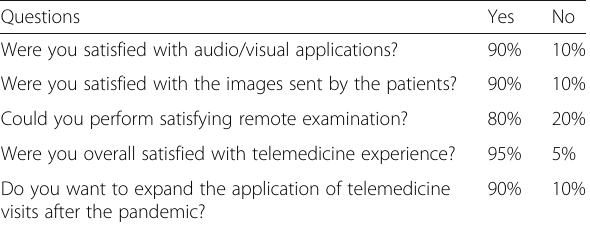
Table 2 Doctor satisfaction